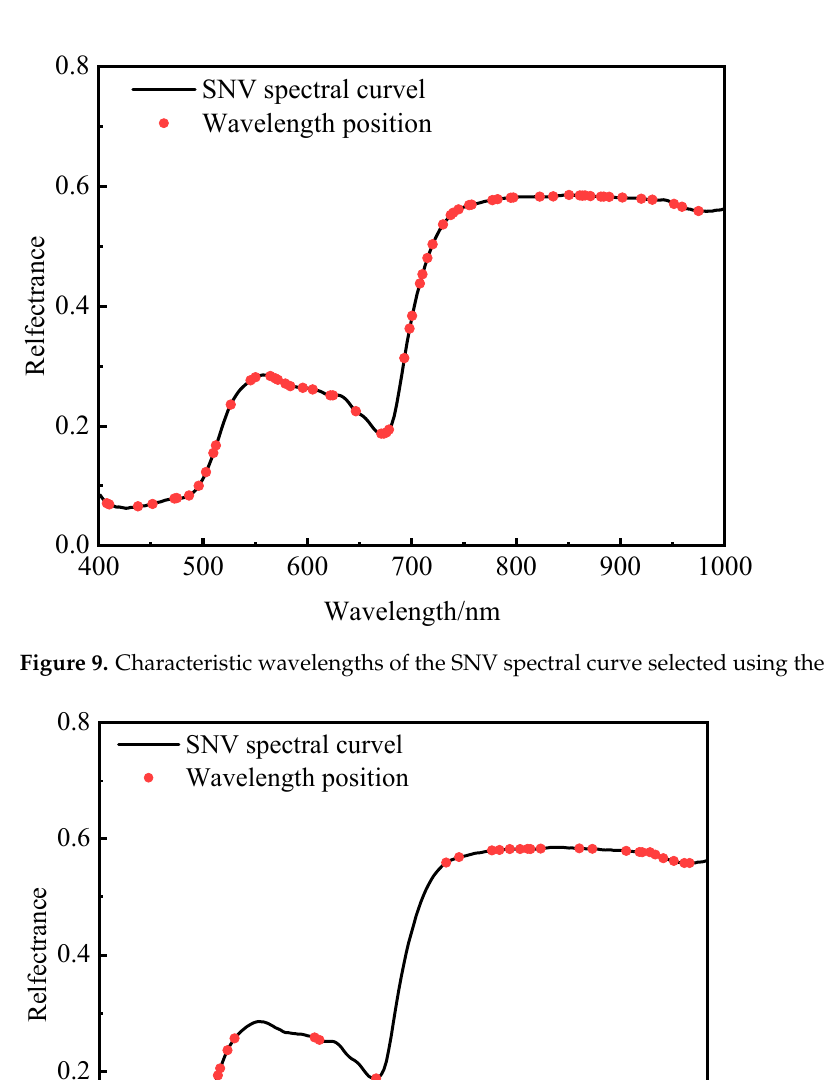
Figure 8. Characteristic wavelengths of the SNV spectral curve selected using the SPA.